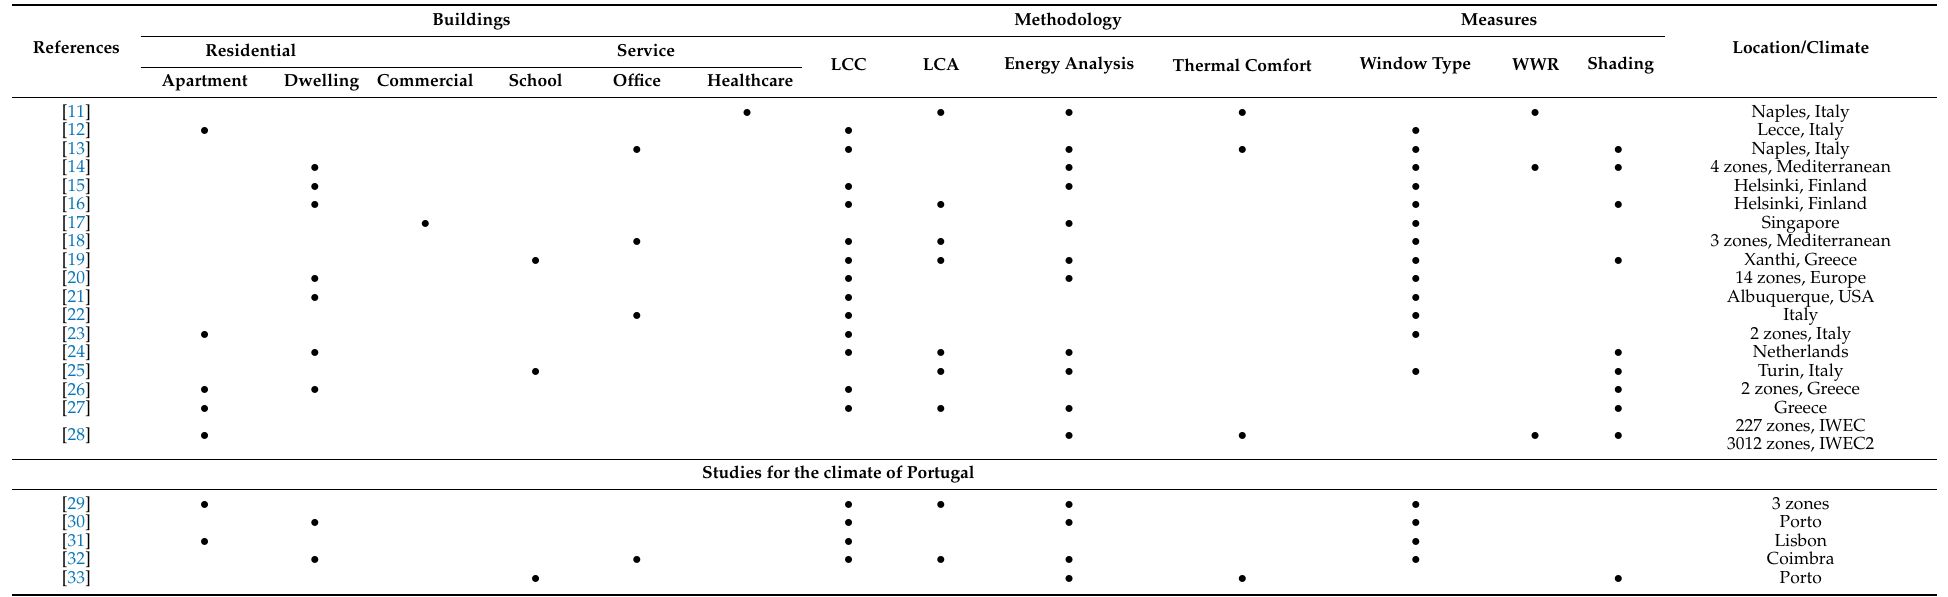
Table 1. Studies about measures to improve the performance of glazing